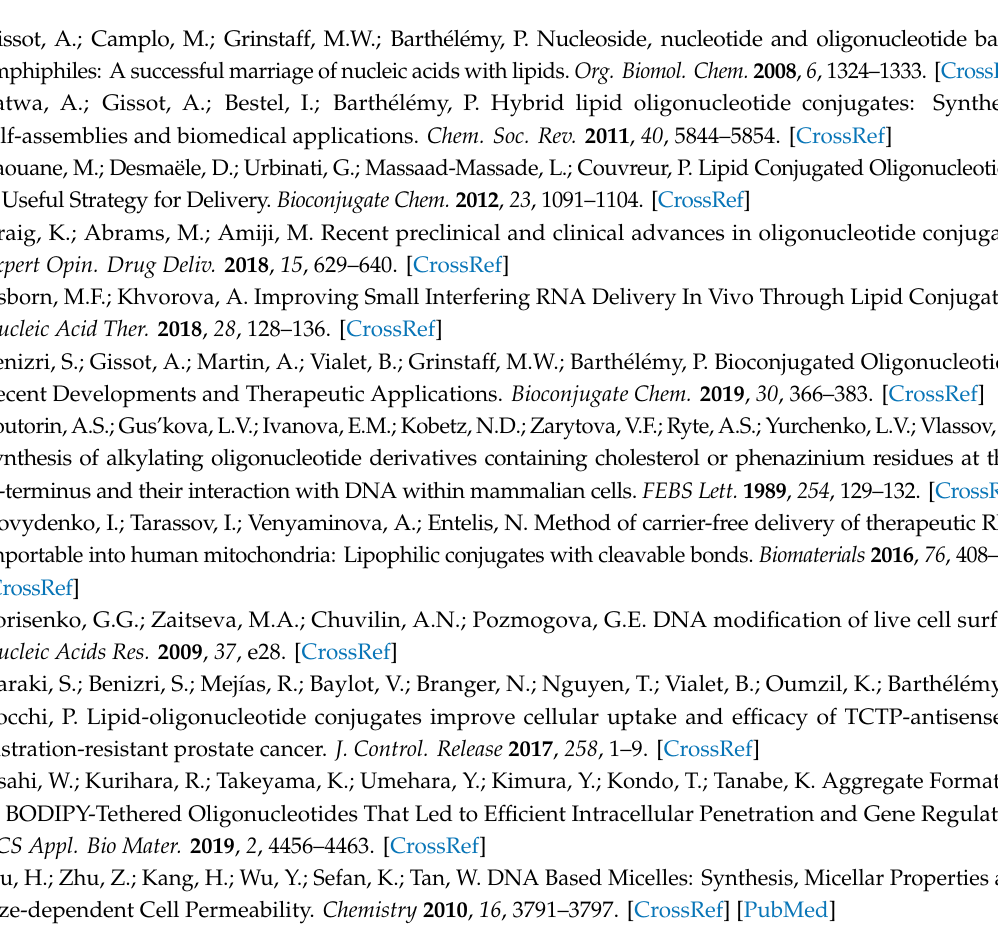
Figure S1: The structure of 3 (cid:48) -FAM CPG used in this work, Figure S2: Comparative electrophoretic mobilities of oligonucleotides and DOCs, Figures S3–S5: The structures of FAM-17-D, D-17-FAM and FAM-D-17 PG conjugates, Figure S6: Typical MALDI TOF and ESI mass spectra of the conjugates, Figure S7,S8: Self-assembly of 17-mer DOC by Nile Red binding assay, Figure S9: Dynamic light scattering measurements, Figure S10: Possible structures of DOCs self-dimers, Figures S11–S16: AFM additional images, Figures S17,S18: TEM additional images, Figure S19: BSA binding with D-13 PG conjugate, Figure S20: Fluorescence quenching additional image, Figure S21: Absorbance spectra of FAM-D-17, FAM-17-D, D-17-FAM, Figure S22: The stability of FAM-D-17 PG conjugate and FAM-17 (cid:48) / D-17 PG duplex used for transfection in 10% FBS, Table S1: Experimental and theoretical molecular masses of the